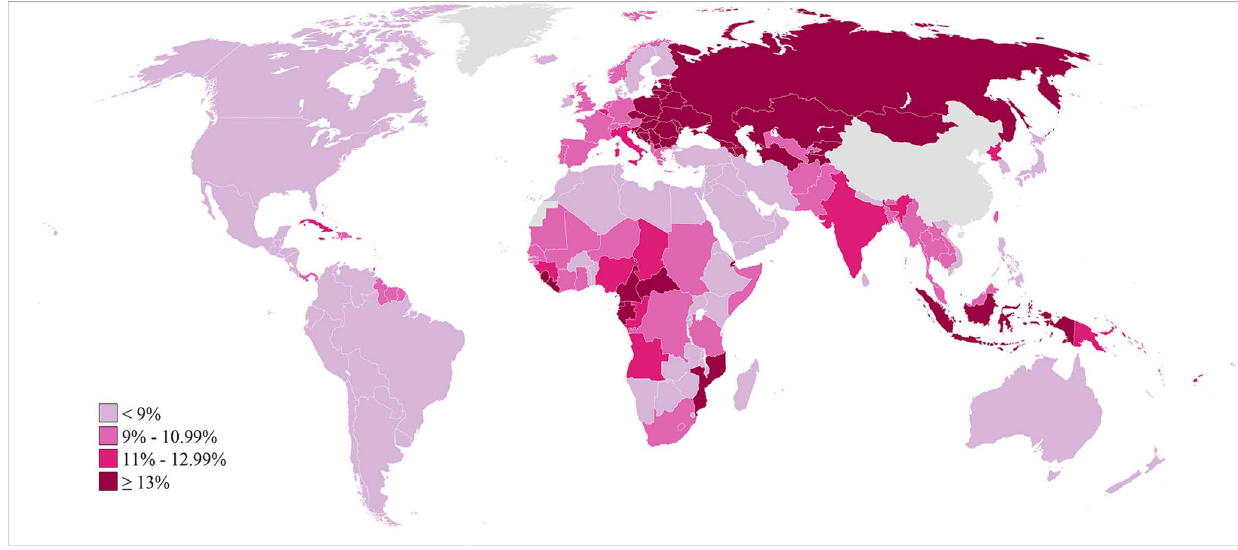
Figure 4. Prevalence of secondary infertility among women who have had a live birth and seek another, in 2010. Infertility prevalence is indexed on the female partner; age-standardized prevalence among women aged 20–44 y is shown